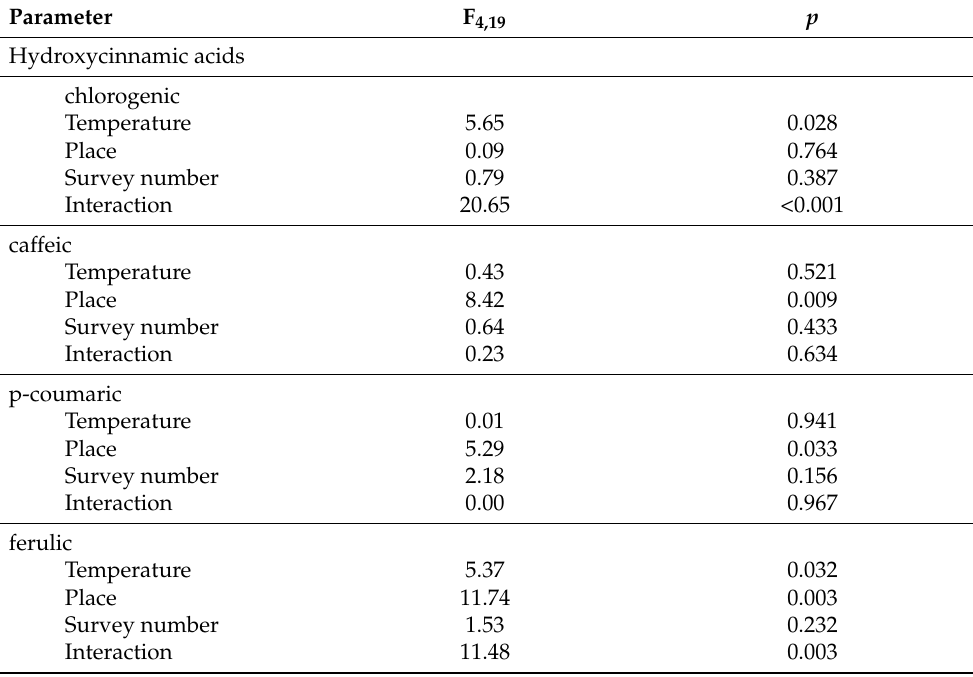
Table 3. The effects of temperature, place, survey number and interaction between studied parameters on level of hydroxycinnamic acids in V. opulus (GLM, normal error